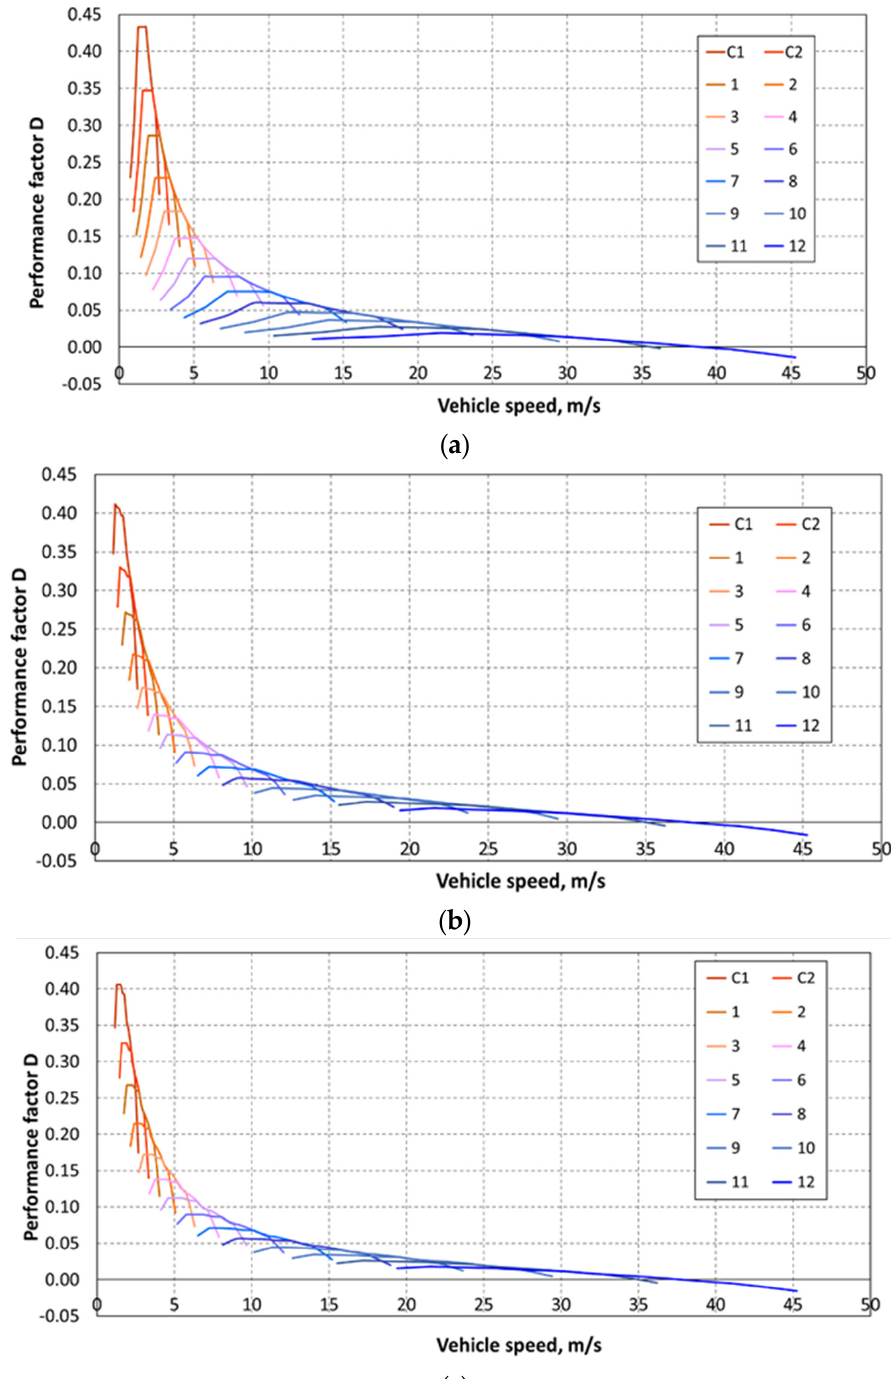
Figure 10. Dynamic characteristics. ( a ) Factory data, ( b ) Diesel and ( c ) Diesel/CNG.